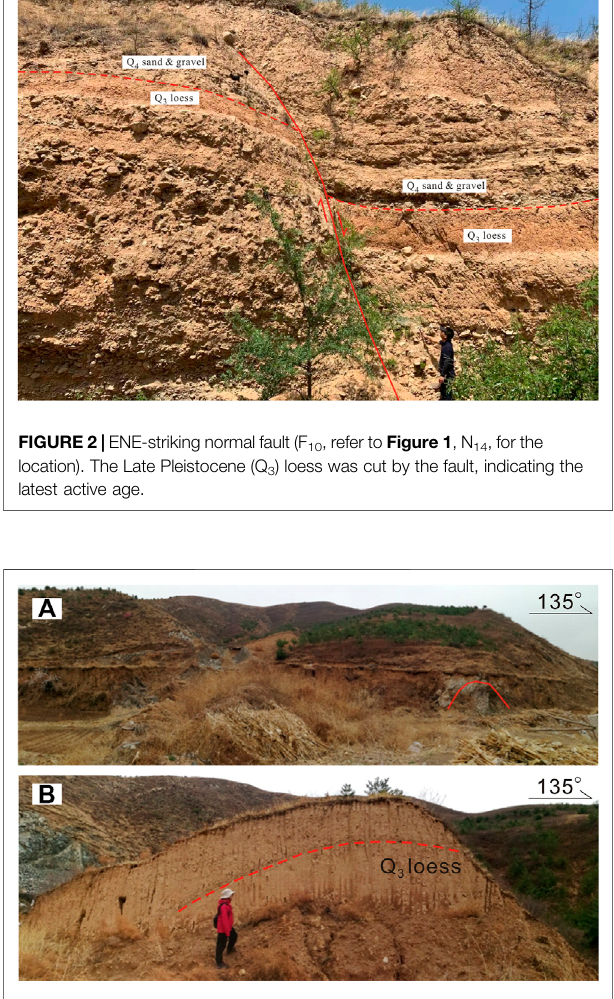
Frontiers in Earth Science |